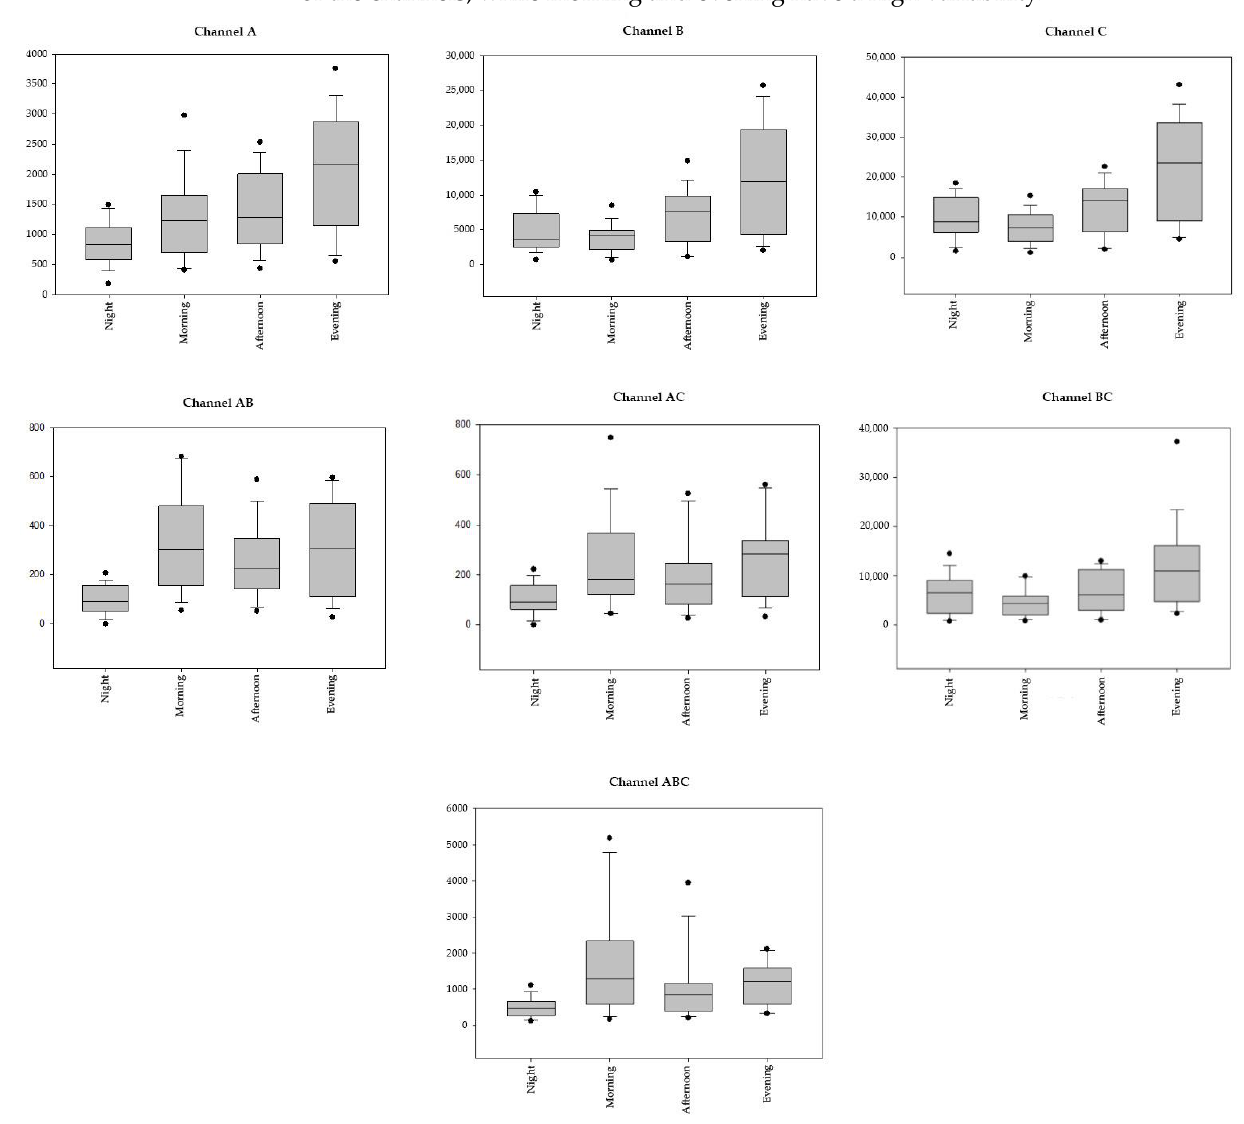
Figure 7. Box plots resulting from the analysis of variance between different parts of the days (x- axis), considering each channel. On the y-axis the number of sampled particles for each section of considering each channel. On the y -axis the number of sampled particles for each section of the day the day is shown. is